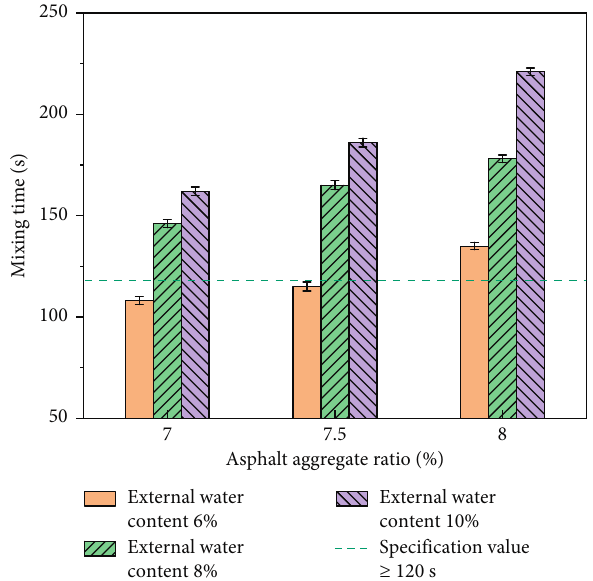
Figure 2: Mixing time under different external water content.